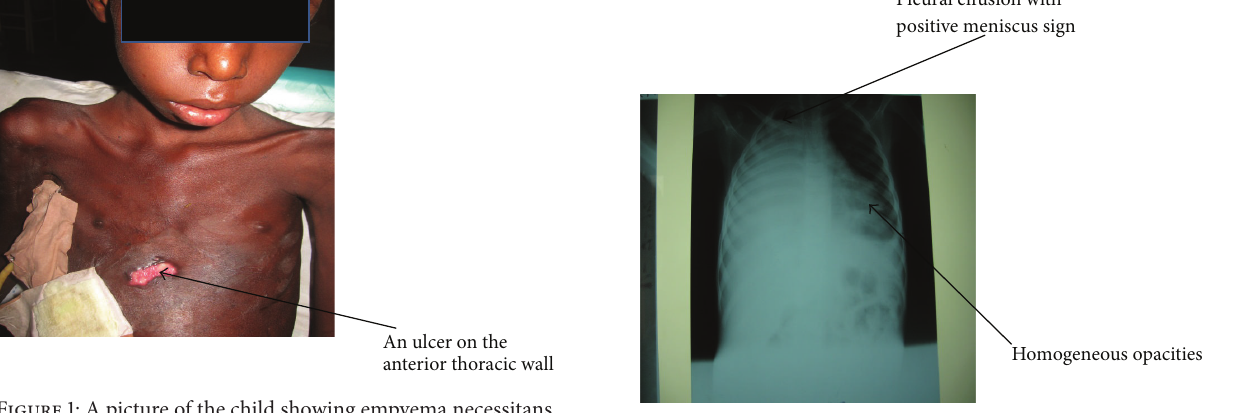
Figure 2: Chest X-ray showing pleural effusion with consolidation.